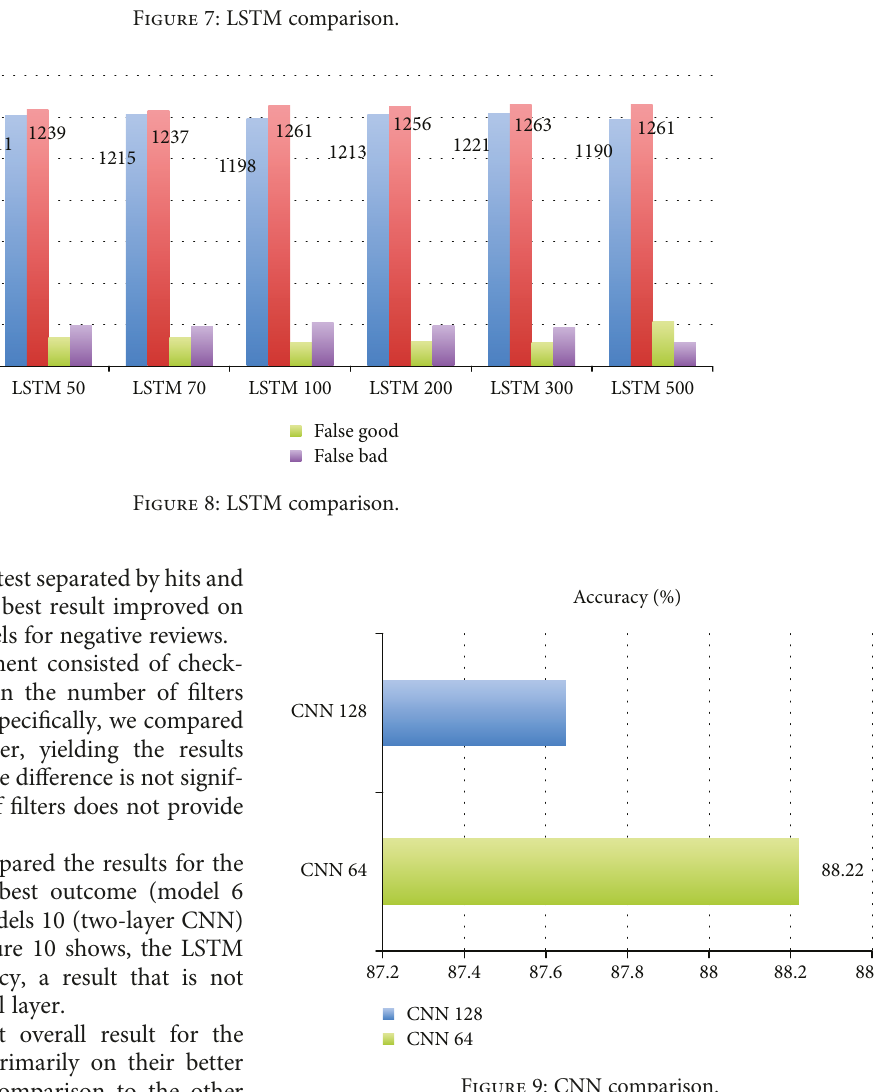
Figure 7: LSTM comparison.